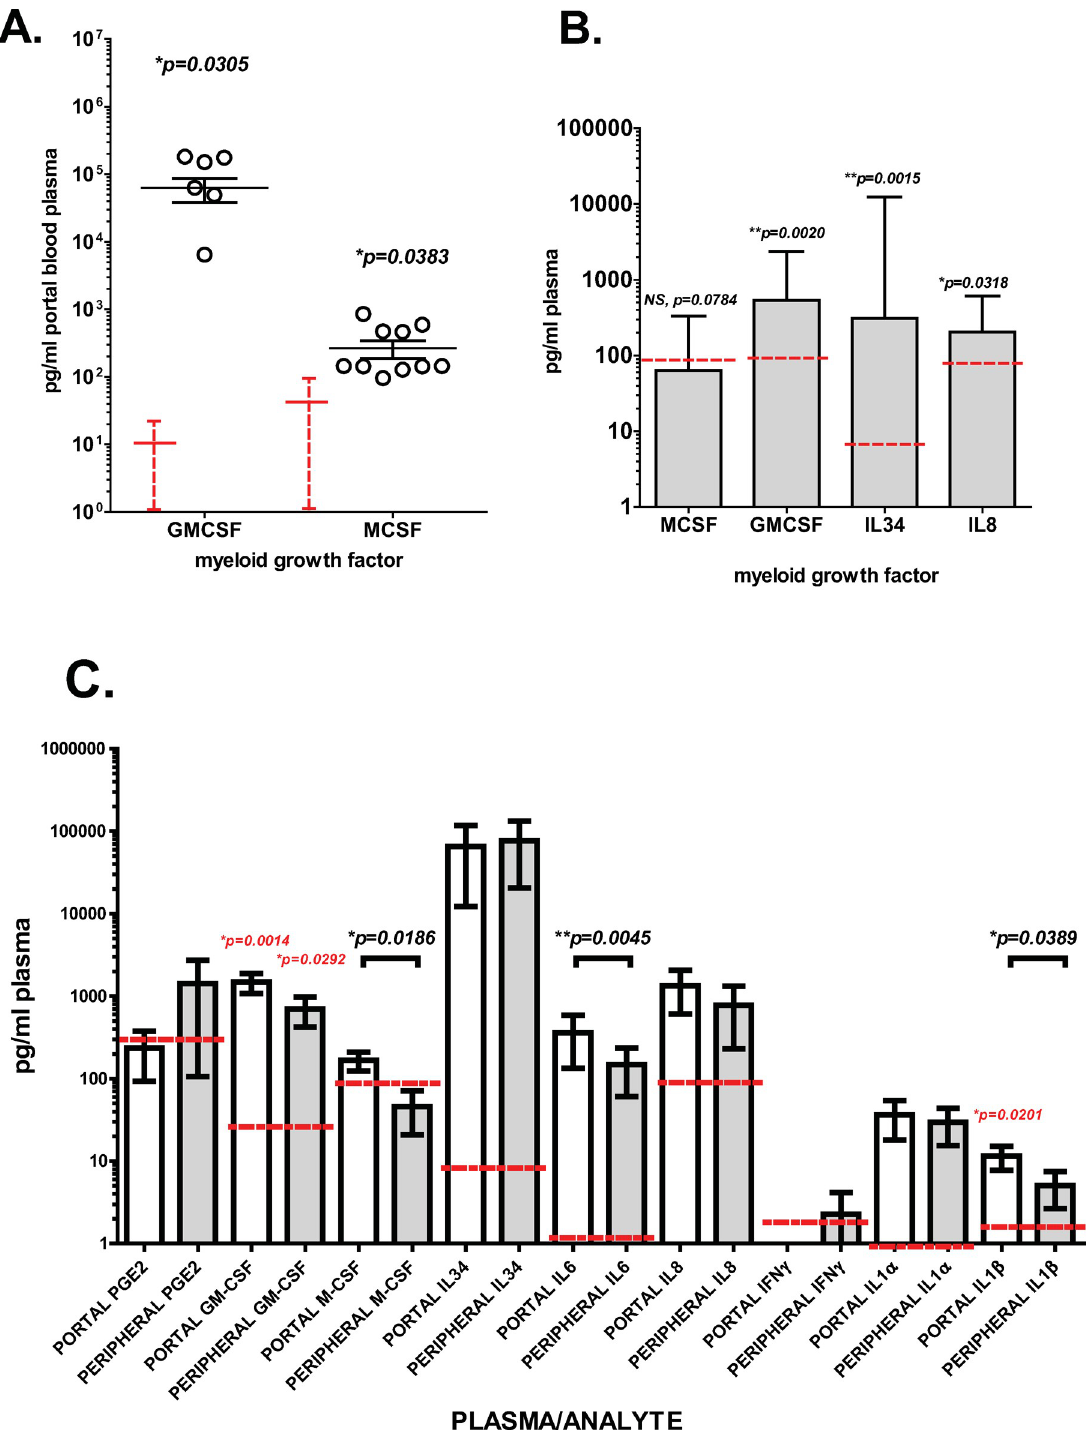
Fig 2. Increased levels of inflammatory and myeloid cell growth factors in PDAC portal blood plasma. ( A ) Portal blood plasma from 11 patients collected immediately after PDAC tumor resection were analyzed in duplicate using Legendplex cytokine multiplex flow cytometric analysis. By this analysis, GM-CSF levels in PDAC patient portal blood plasma were found highly elevated compared to normal peripheral blood levels (depicted by red dotted line mean + SD, p = 0.0305). M-CSF levels were moderately elevated over normal levels (red line and dotted line depicts control mean + SD, p = 0.0383). Sample values are depicted as open circles, lines indicate mean of sample values with error bars showing standard error from the mean. ( B ) Portal blood plasma from 24 PDAC patients were analyzed for